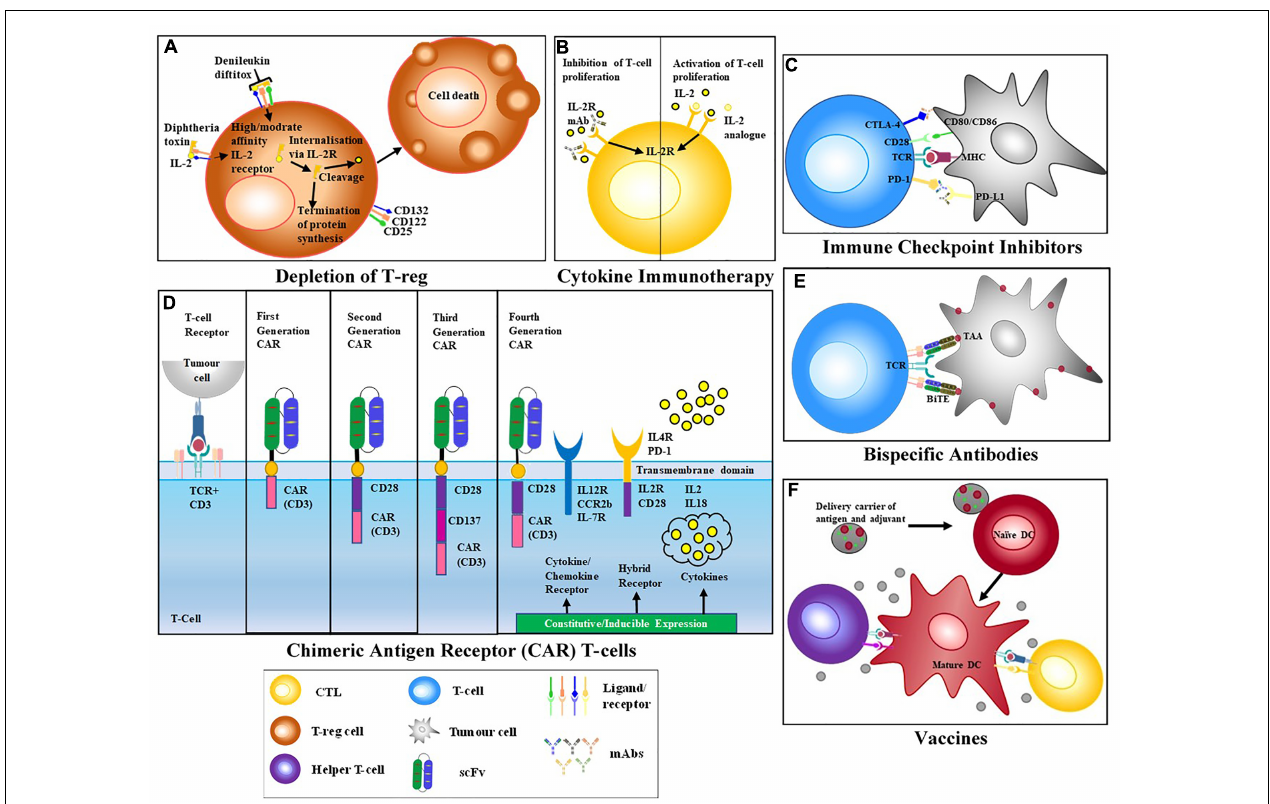
FIGURE 1 | T cell-activating Therapeutic Strategies. (A) Treg depletion – biologics such Denileukin diftitox (DD) bind to target receptors on suppressor cells and initiate apoptosis via down-stream signaling. (B) Cytokine therapy – addition of pro-inflammatory cytokines increases immune activation while the addition of anti-inflammatory cytokines reduces immune activation. MAbs specific for cytokine receptors may also be used to block cytokine stimulation of the immune system. (C) Immune checkpoint blockade – mAbs block the interaction of inhibitory receptors CTLA-4 and PD-1, resulting in the activation of effector T cells (QYResearch) (D) Chimeric antigen receptors (CARs) T cells are modified T cells with a recombinant receptor; usually a scFv that redirects the specificity of effector T cells. First generation CARs that only comprised an activation domain were prone to anergy. Due to this signaling failure, second and third generation CARs, incorporating a CD3 chain and cytoplasmic domain of a co-stimulatory receptor, like CD28 were generated. Fourth generation CARs also included constitutive or inducible expression of co-receptors or soluble cytokines together with T cell activating CAR (Golubovskaya and Wu, 2016). (E) Bispecific antibodies containing two binding arms one specific for a target antigen and a second arm specific for CD3, thereby bringing T cells into close proximity to target cells and activating T cells while bypassing the need for MHC restricted engagement. (F) Vaccines – Introduction of non-infectious component to stimulate activation of T cells and development of memory immune